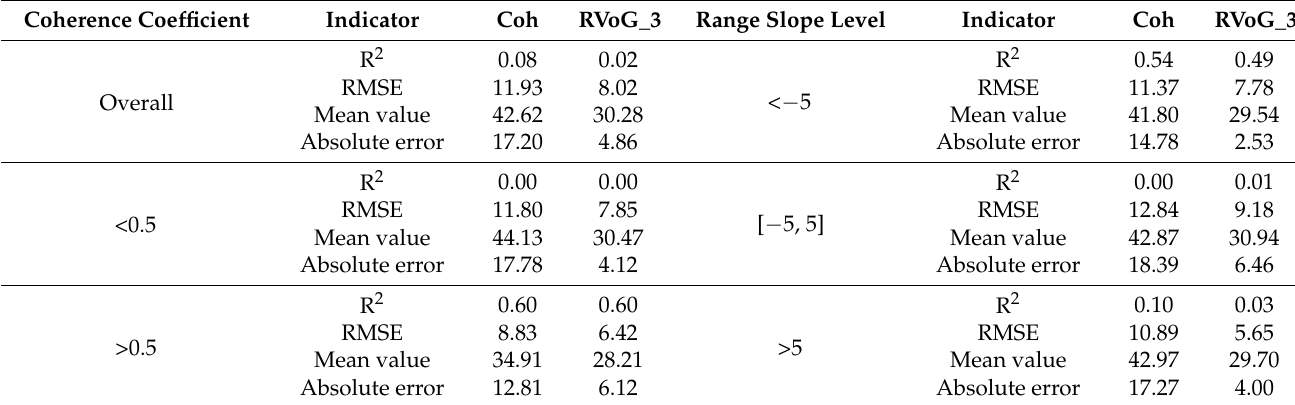
Table 7. The accuracy statistics of the results from Coh and RVoG_3 algorithms considering noise decoherence, pre- processing decoherence, and baseline distance decoherence. Coherence Coefficient Indicator Coh RVoG_3 Range Slope Level Indicator